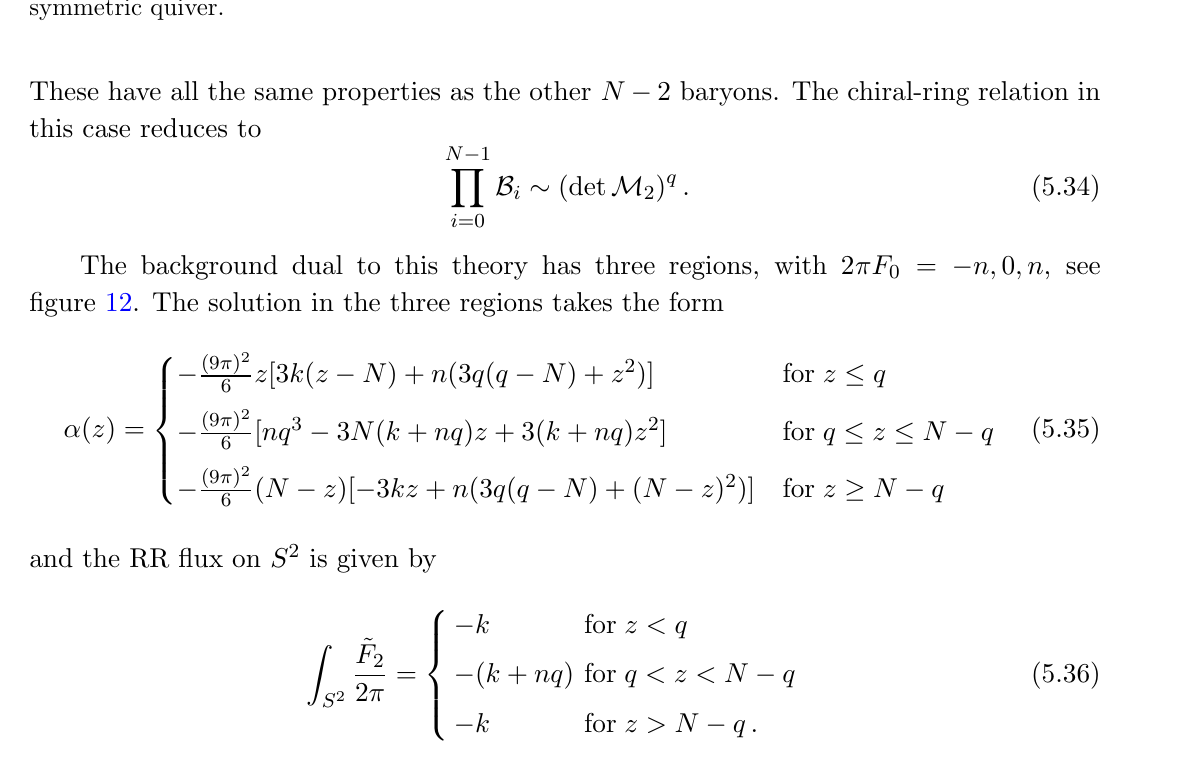
3 dual to the three-segment